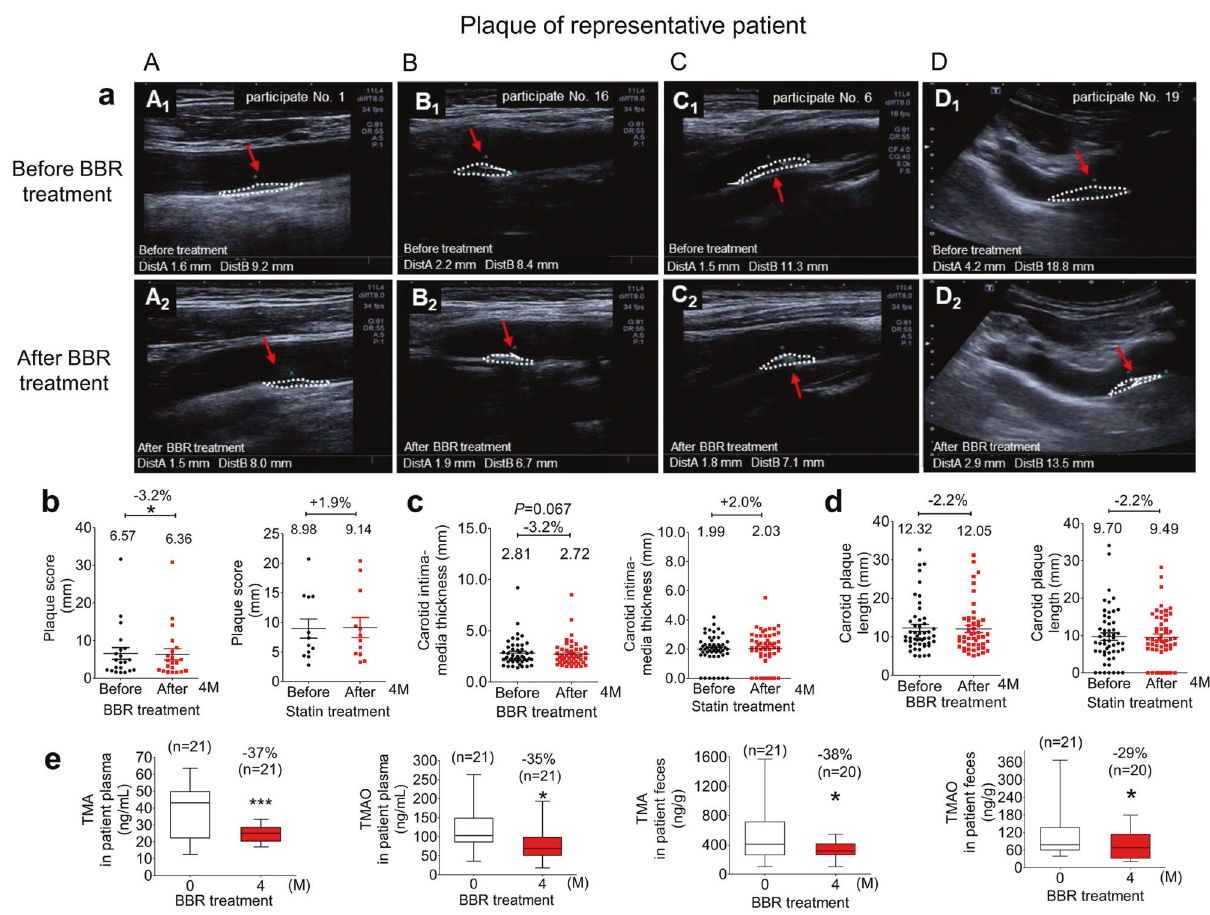
Fig. 6 BBR reduced the plaque size in patients with atherosclerosis. a The ultrasonic images of atherosclerotic plaques (circle in white) of the patients at different positions of carotid arteries before (1) and after (2) 4-month BBR therapy are shown, including the common carotid artery (A: participate No. 1, plaque No. 1), the carotid bifurcation (B: participate No. 16, plaque No. 38), the internal carotid artery (C: participate No. 6, plaque No. 19) and the subclavian artery (D: participate No. 19, plaque No. 44). Also, please see Table S9 in the supplemental material. b The average plaque score in patients was decreased by 3.2% after oral BBR (0.5 g, bid) for 4 months (* P < 0.05, n = 21); the score value was slightly increased (by + 1.9%) after treatment with conventional drug combination, including rosuvastatin, aspirin, as well as clopidogrel sulfate or ticagrelor ( n = 12) if needed. c The average carotid intima-media thickness was reduced by 3.2% after oral treatment with BBR ( P = 0.067), and the value was slightly increased (by + 2.0%) in the combination therapy. d The average carotid plaque length in patients was decreased by 2.2% in either oral BBR (0.5 g/bid) group or combination drug group after 4 months on therapy. e TMA and TMAO level in faeces and plasma samples of patients went down after 4 months BBR treatment; the TMA/TMAO levels in plasma were lowered by 37% / 35% (*** P < 0.001; * P < 0.05), and TMA/TMAO levels in faeces decreased by 38%/29% (* P < 0.05; * P < 0.05). Data shown are the mean ± SEM and analysed with one-tailed paired t reference of known drugs [Group 3, age 55.60 ± 8.85; 10 males and 2 females]. Their baseline was as following, TC (mmol/L), 4.53 ± Table S8). The average levels of TC and LDL-C returned to the 1.10; TG (mmol/L), 1.54 ± 0.51; LDL-C (mmol/L), 2.77 ± 0.73; and normal range (Supplementary Table S7), con fi rming the systemic FBG (mmol/L), 7.71 ± 3.44; they were treated with rosuvastatin therapeutic ef fi cacy of BBR for blood lipids and glucose. TMA in